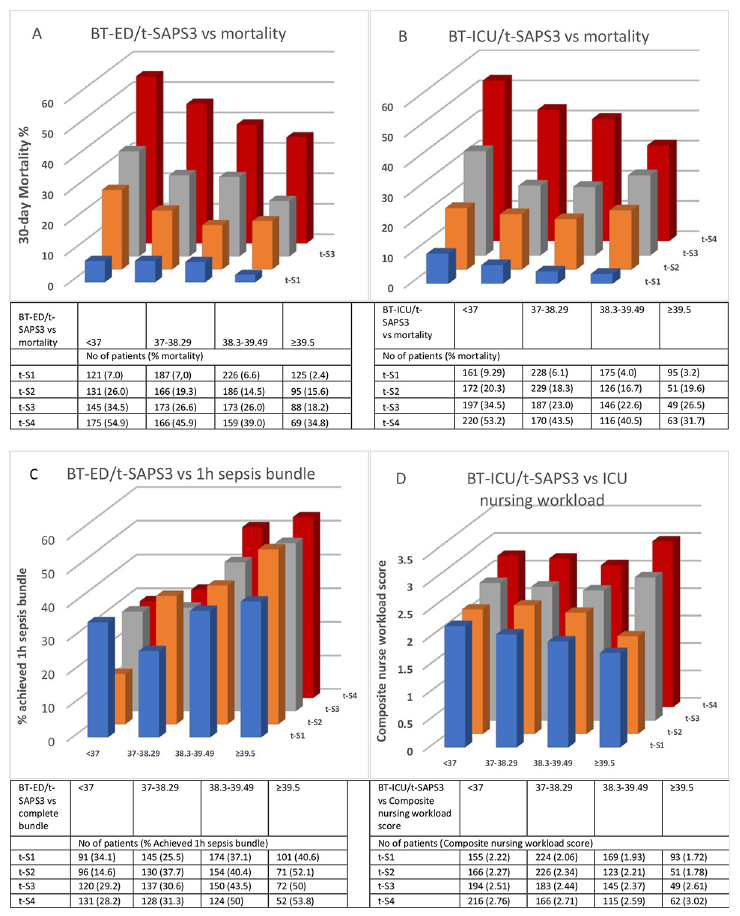
Fig 3. Body temperature in the ED ( A and C ) and the ICU ( B and D ) stratified by quartiles of t-SAPS3 (t-S1 lowest quartile) versus 30-day-mortality ( A and B ), achieved one-hour sepsis bundle (all four components) ( C ) and composite ICU nursing workload score ( D ). BT-ED: body temperature in the Emergency Department, BT-ICU: body temperature in the ICU, SAPS3: Simplified Acute Physiology Score 3, t-SAPS: SAPS minus temperature score for patients with body temperature < 35˚C (n =